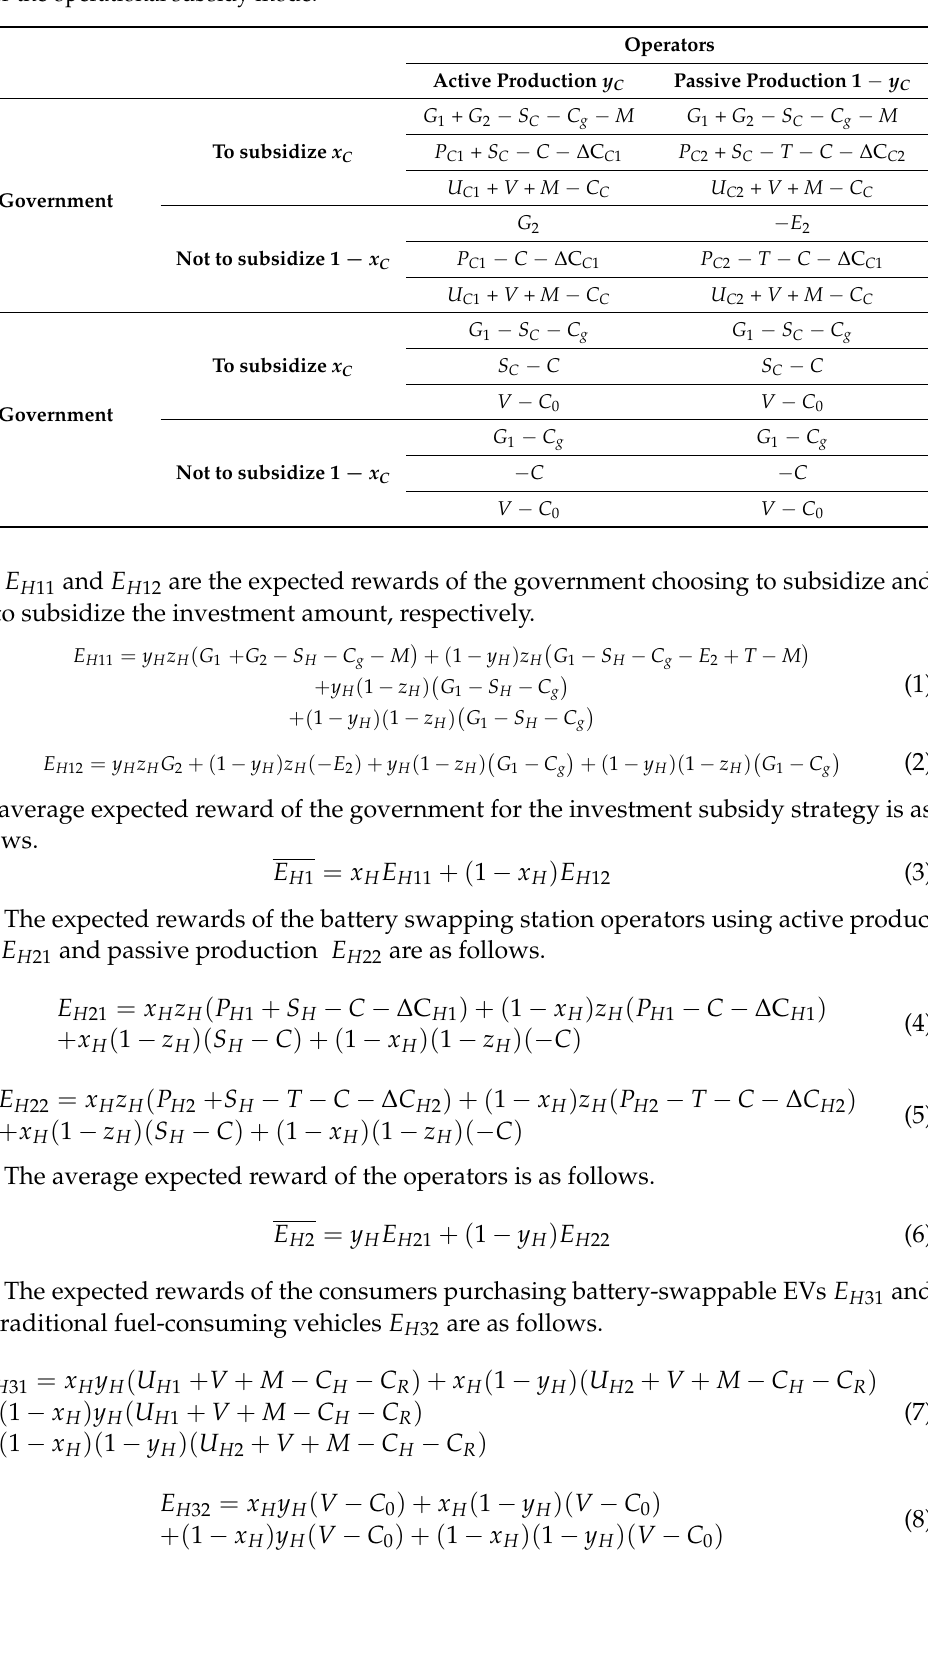
Table 2. Reward matrix in the evolutionary game among the government, operators, and consumers under the operational subsidy